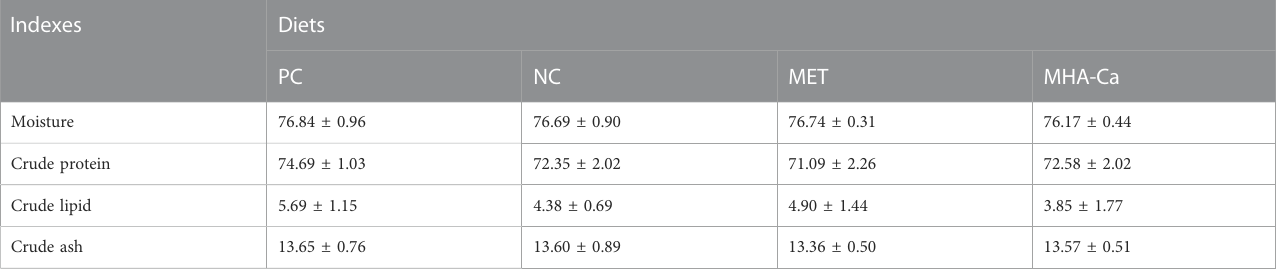
TABLE 5 Whole-body composition of L. vannamei fed the experimental diets (% dry matter).